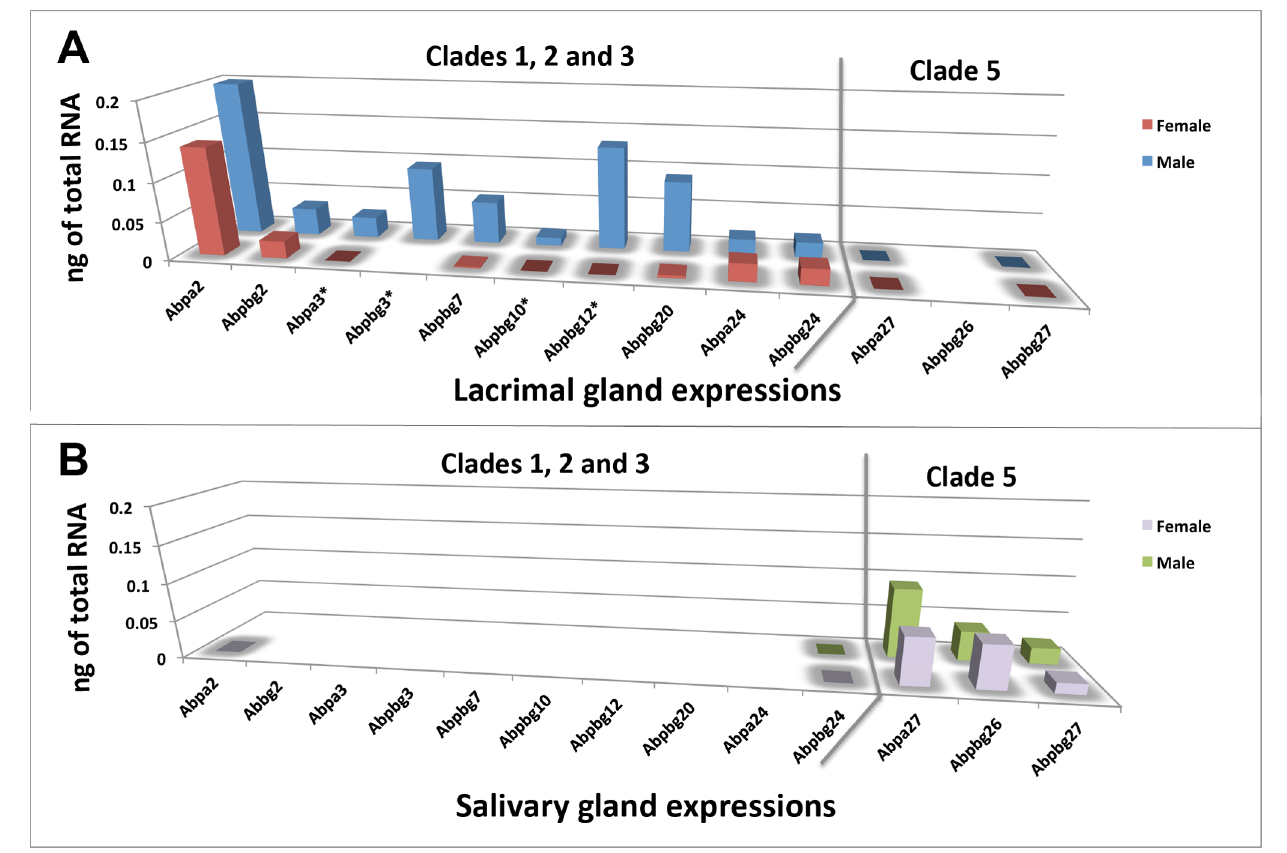
Fig. 3. A comparison of Abp transcript levels in mouse lacrimal (Panel A) and salivary (Panel B) glands. Expression levels were determined by qPCR ( S9 File in S1 Appendix ) and these values are compared with female values in front and male values behind. Paralogs a12 and a20 were excluded because of multiple banding. Color legends appear to the right of each graph; the grey line demarcates paralogs found in Clades 1–3 and Clade 5. Paralogs with male sex-limited expression are marked with asterisks. Those paralogs shown by white space are undetectable by qPCR (this varies from the sequence-based identifications in Fig. 1